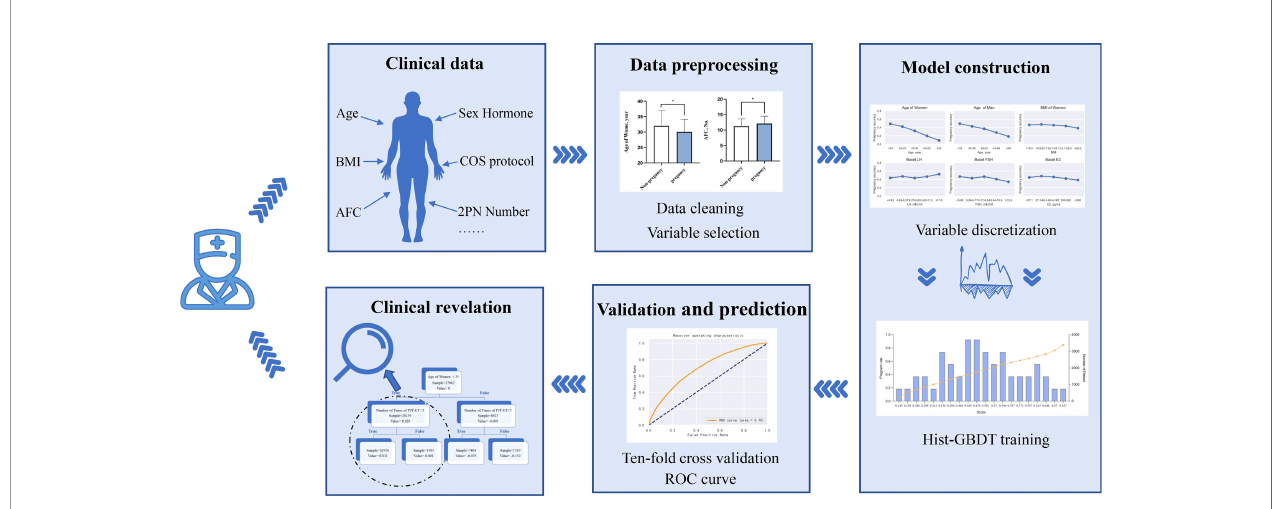
FIGURE 1 | Flow chart of the study This fi gure described the fl ow sheet of the study. GBDT (Gradient Boosting Decision